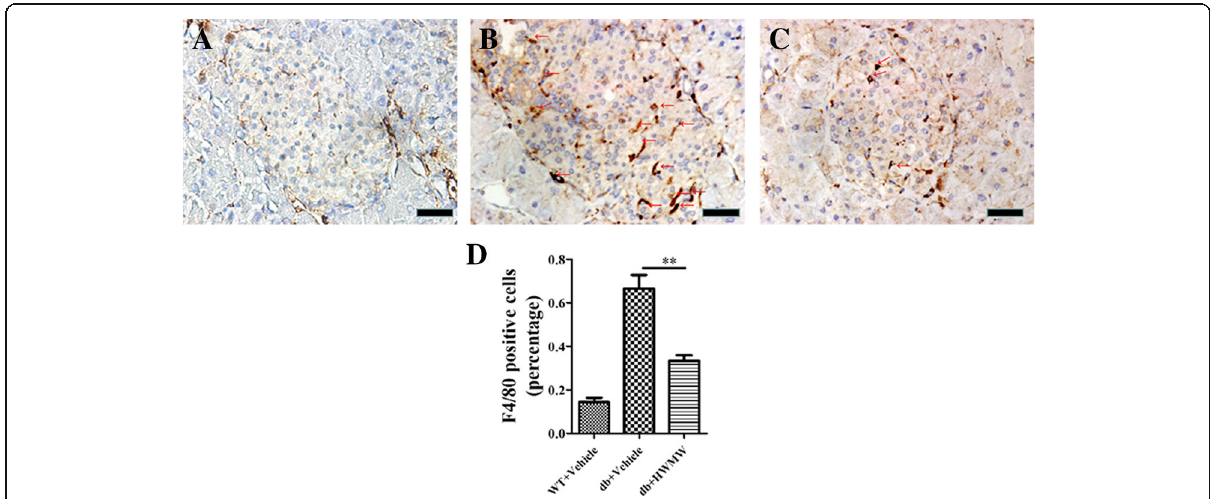
Fig. 6 Effect of WMW on macrophage infiltration in the mouse pancreas. Immunohistochemistry staining for F4/80 in mouse islets from the pancreas of ( a ) wild-type; ( b ) db/db; ( c ) db/db mice treated with HWMW and ( d ) the bar graph for percentages of F4/80 positive cells (red arrows). Scale: 25 μ m. P < 0.01 (**) ( n =